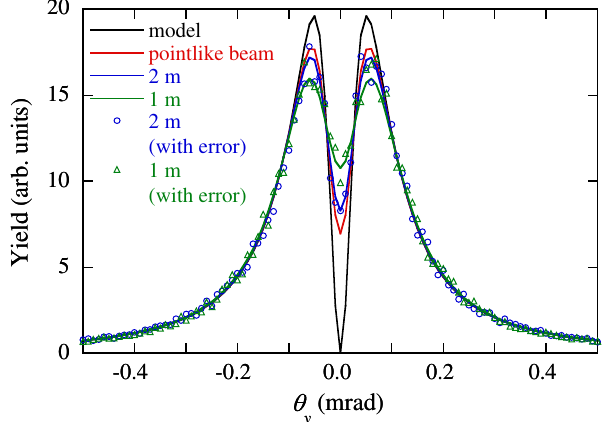
FIG. 7. Dependence of the beam size estimates on the distance between the crystal and the detector. Silicon; electron energy 10 GeV; observation angle Θ D ¼ 32 . 2 °; σ x ¼ 20 μ m; σ ¼ 30 μ m. y